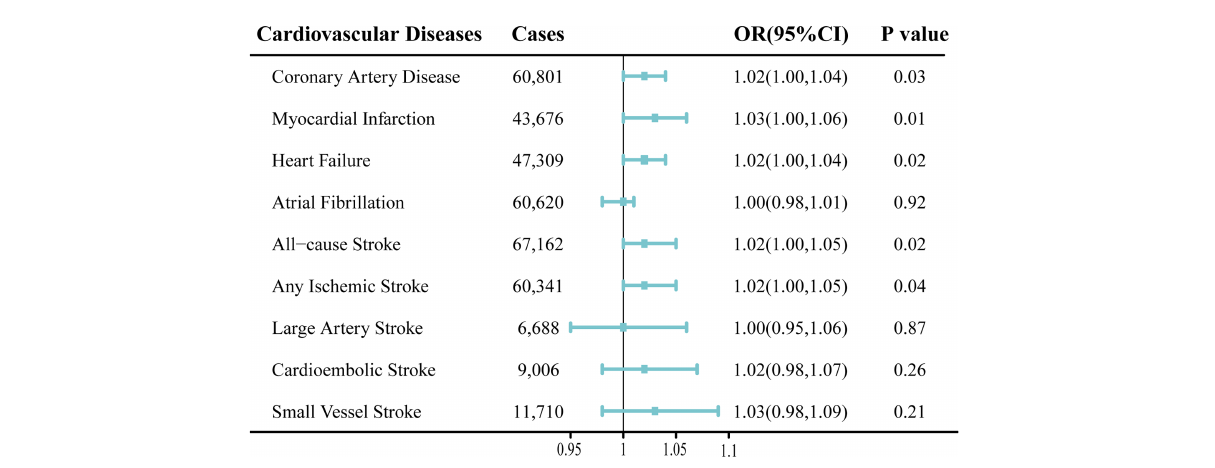
FIGURE 2 | Mendelian randomization analysis estimates of multiple sclerosis and the risk of cardiovascular diseases. Odds ratios are scaled to per genetically predicted 1 log-odds unit increase in the liability to multiple sclerosis. OR, odds ratio; CI, con fi dence interval.